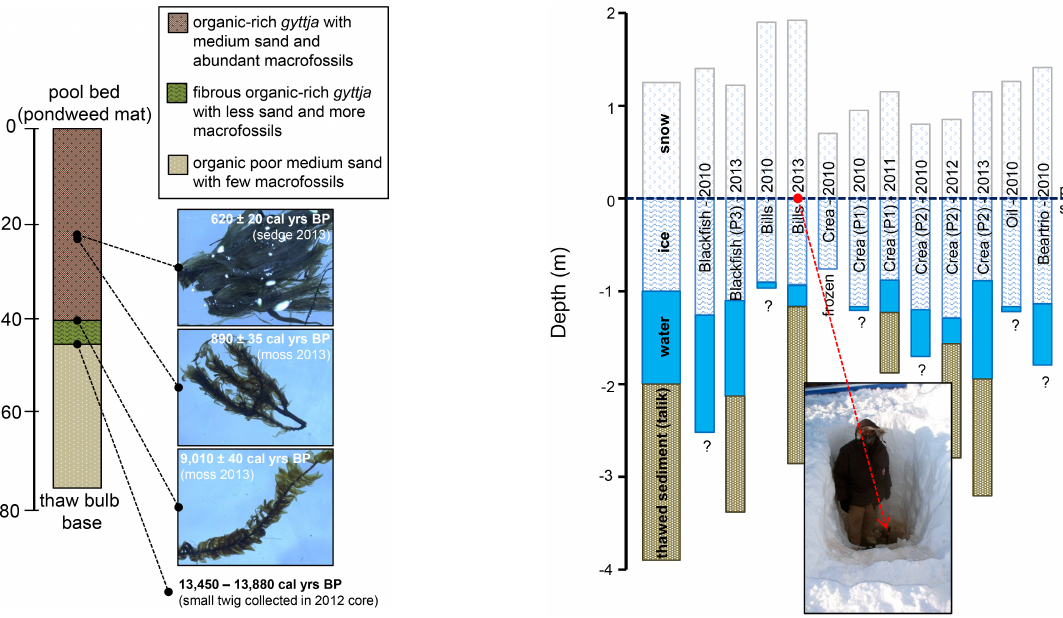
Figure 11. Late winter profiles (March or April) of several pools (beads) surveyed in multiple beaded streams from 2010 to 2013 (“?” indicated that no measurement of thawed sediment depth was at- tempted). An example photograph from one pool surveyed in 2013 shows a 1.9m tall person (G. Grosse) standing on the frozen pool surface for